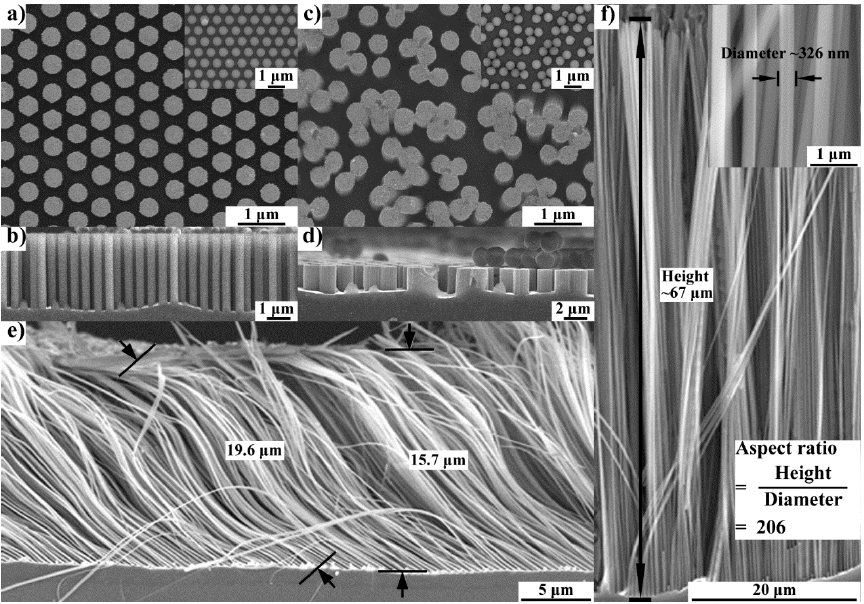
Figure 5. SEM images of Si nanowires fabricated by metal-assisted chemical etching (MACE). ( a ) Separated Si nanowires obtained using the separated PS nano-sphere array as the template (inserted). ( b ) Section view of the separated Si nanowires when they are short. ( c ) Coalesced Si nanowires obtained using the coalesced PS nano-sphere array as the template (inserted). ( d ) Section view of the coalesced Si nanowires when they are short. ( e ) Collapsed separated nanowires fabricated using the template in (a). ( f ) Ultra-long coalesced nanowires fabricated using the template in (b). An aspect ratio